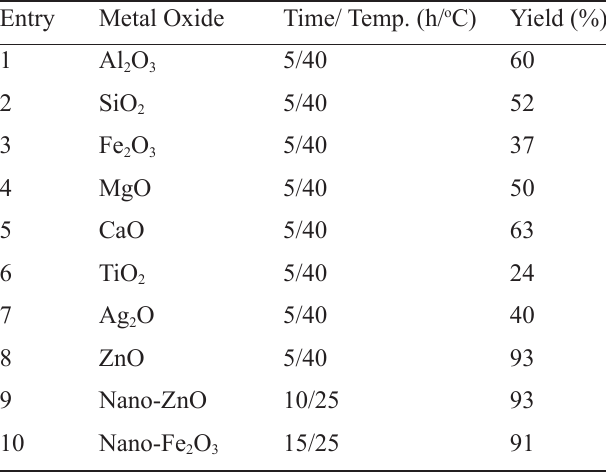
Table 1. Benzoylation of ethanol with benzoyl chloride in the presence of metal oxide